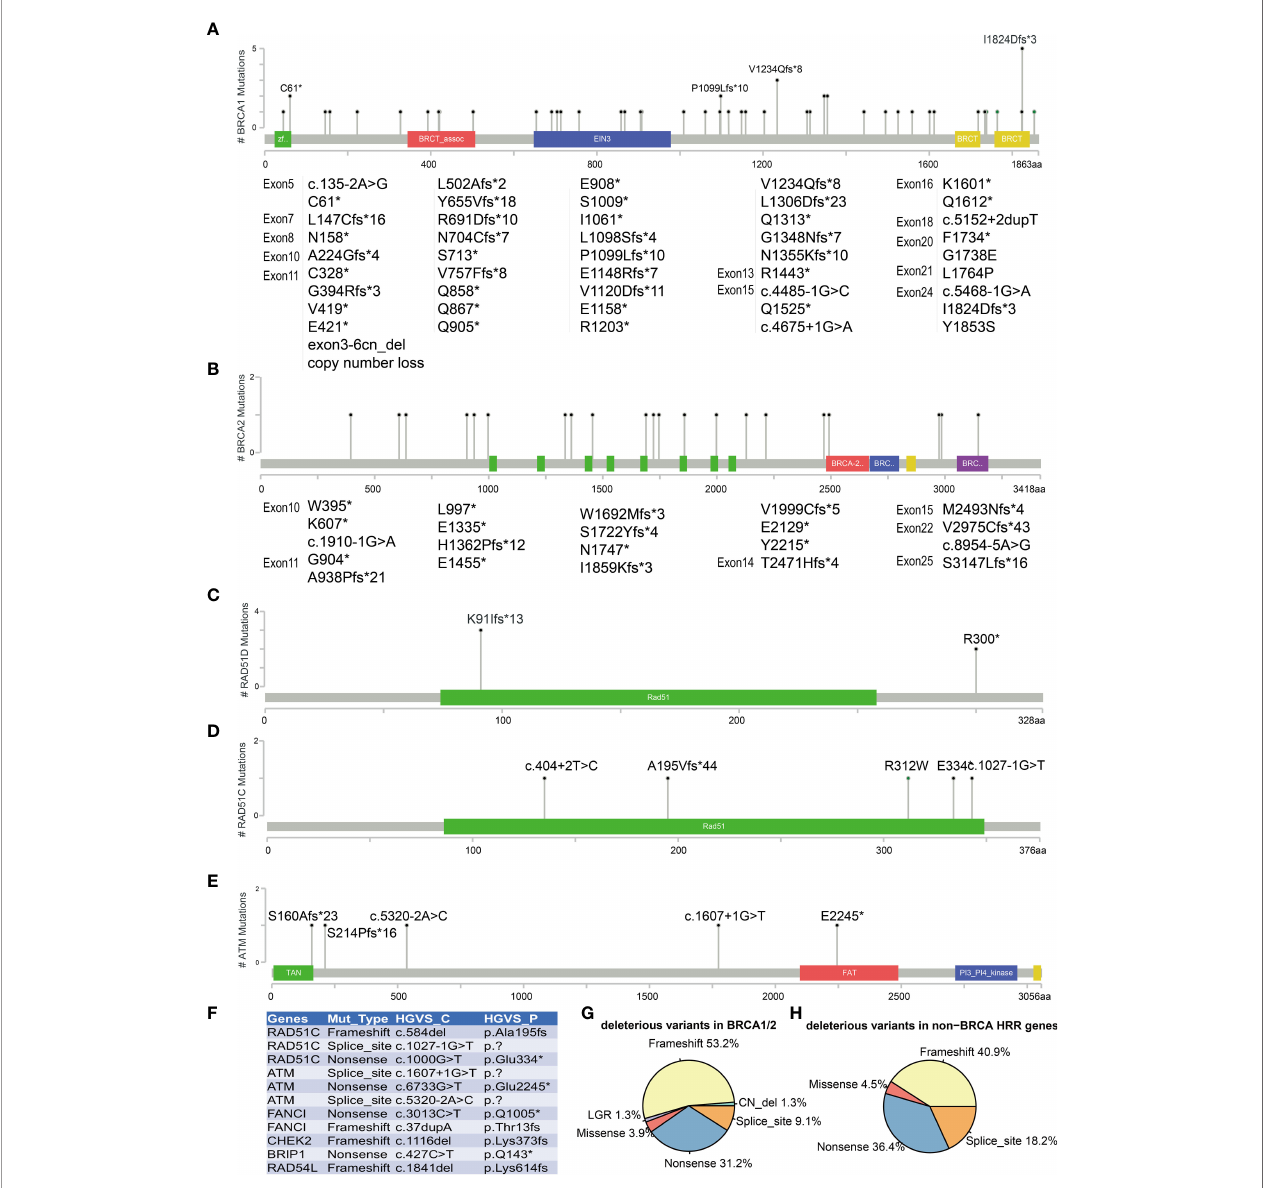
FIGURE 3 | Mutations landscape of BRCA1 (A) , BRCA2 (B) , RAD51D (C) , RAD51C (D) , and ATM (E) genes. The X -axis represents the amino acid residues of the proteins, and the Y -axis represents the frequencies of each type of mutations. (F) List of 11 novel non-BRCA HRR variants. Distribution of mutation types in BRCA1/2 (G) and non-BRCA HRR genes (H) . The symbol * means the variant is a nonsense mutation in